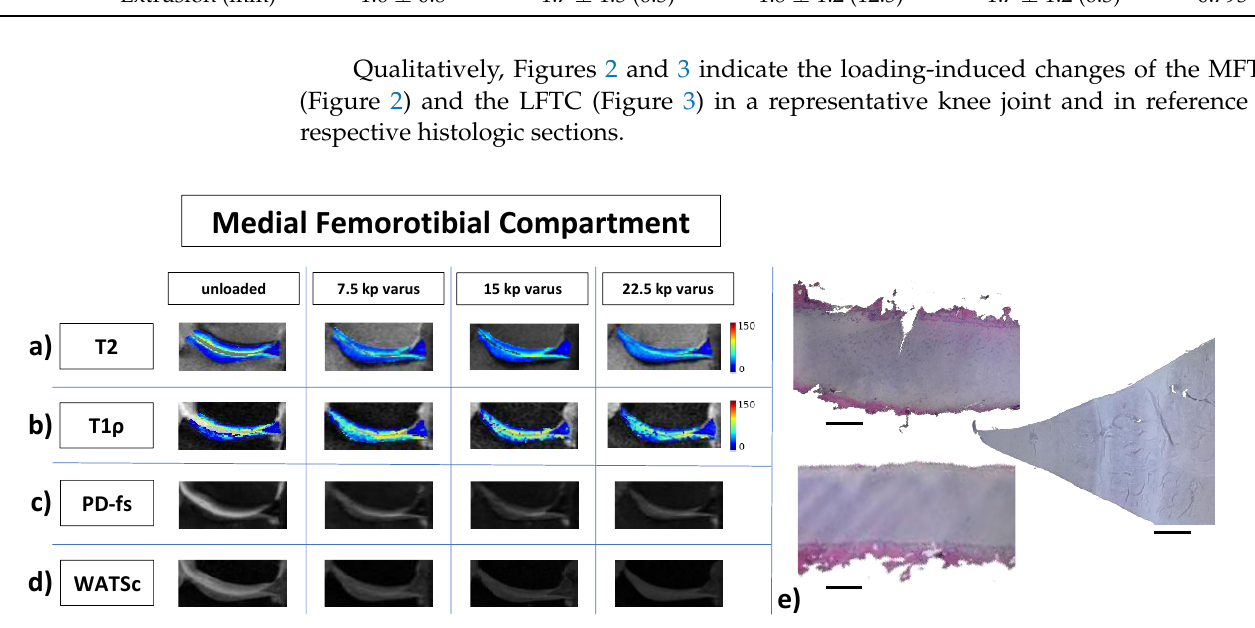
Figure 2. Representative multiparametric MR images of the medial femorotibial compartment in response to varus loading and corresponding histologic sections. ( a – d ) Displayed are T2 maps ( a ), T1 ρ maps ( b ), and morphologic images, i.e., proton density-weighted fat-saturated (PD-fs, ( c )) and water selective cartilage scan images (WATSc, ( d )) as a function of increasing varus loading intensity. Segmentation outlines were overlaid onto the corresponding morphologic images and pixel intensities were color-coded (ms). MR images were cropped and zoomed to the areas of interest. ( e ) Corresponding histologic sections of the tibial cartilage (bottom), the femoral cartilage (top), and medial meniscus (right side) after hematoxylin-eosin staining. Bars indicate 1 mm. Same right knee joint as in Figures 1 and